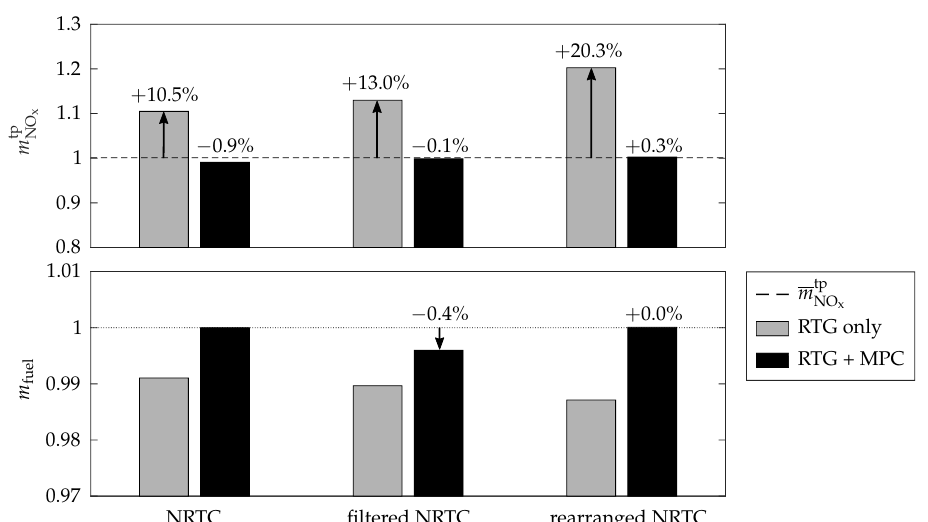
Figure 12. Comparison of the measured operation for different misprediction cases. The results obtained without feedback from the MPC are shown in gray, while the results obtained with the full predictive supervisory controller are shown in black. The emitted tailpipe NO x mass is normalized with respect to the limit, while the fuel mass is normalized with respect to the operation with the full predictive supervisory controller for the case without